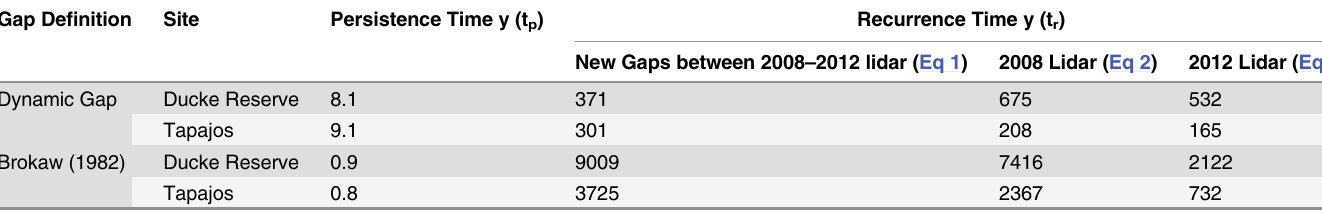
Inter-sample period growth takes into account both height gain and height loss in gap areas. Three recurrence frequencies are presented: (1) Taking into account only areas that were not in gap in the 2008 lidar scene (Eq 1), (2) Using the entirety of the 2008 lidar scene (Eq 2), (3) Using the entirety of